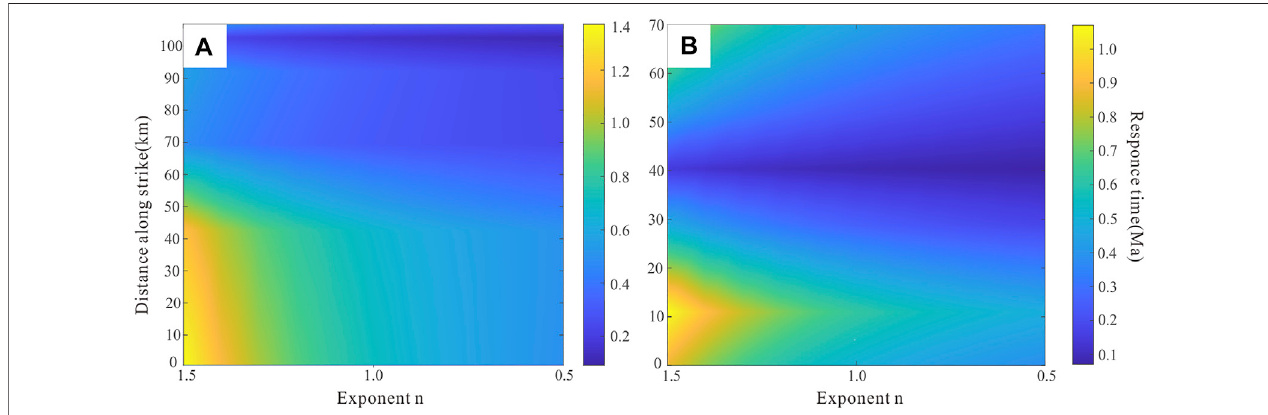
FIGURE 8 | Calculated response time along the direction of the Helan Shan. Yellow represents a larger response time while blue represents a smaller response time. The ordinate represents the projection distance of the streams along strike from the southernmost stream to the northernmost stream. (A) represents the eastern Helan Shan, using stream 10 as the starting point and (B) represents the western Helan Shan, using stream 40 as the starting point.